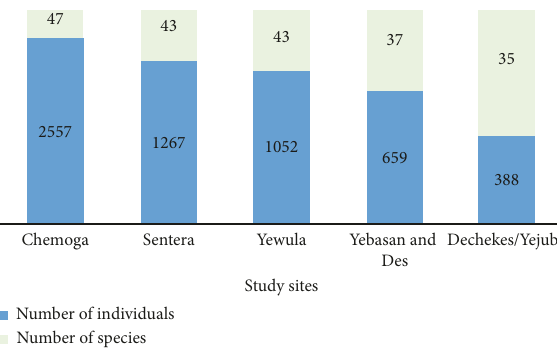
Figure 5: Species and abundance rank of bird species in the study sites during the study